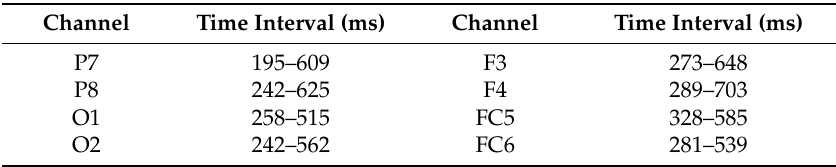
Table 1. Selected channels and time